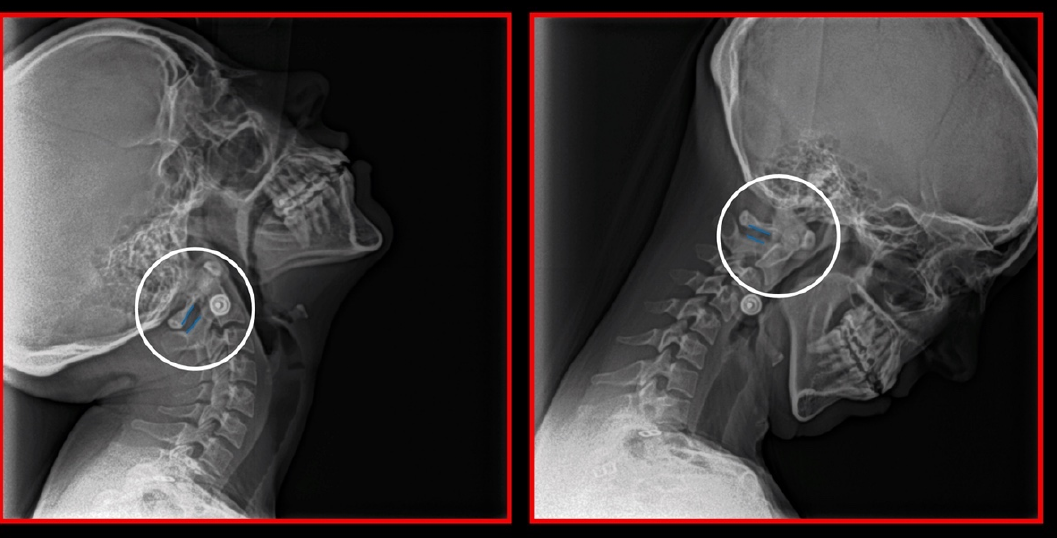
Figure 13. Decreased space between the posterior arch of the atlas and spinous process of C 2 in maximal flexion and extension of the cervical spine. Dynamic lateral cephalometric study.